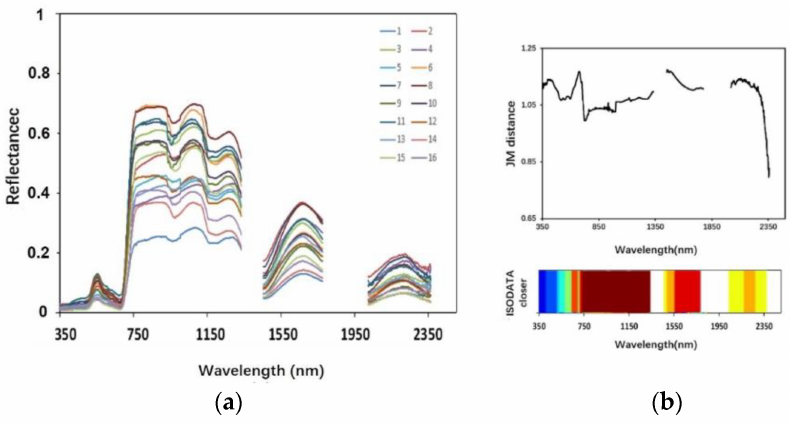
Figure 2. ( a ) Canopy spectra of sixteen crops; ( b ) the results of band JM distance ISODATA clustering. (The species ID is referred from the Table A1. The same color indicates the same